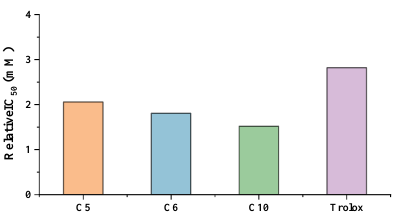
Figure 6. The relative IC 50 of potential ligands with SOD. C5: N - trans - p -coumaroyloctopamine; C6: N - trans -feruloyloctopamine; C10: N - trans